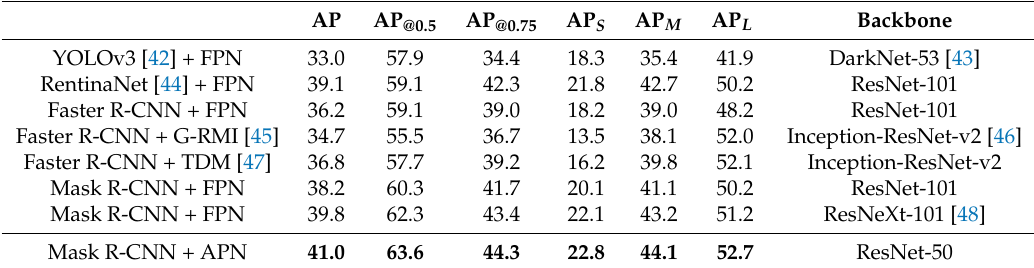
Table 1. Comparisons of single model results on the MS COCO object detection benchmark.